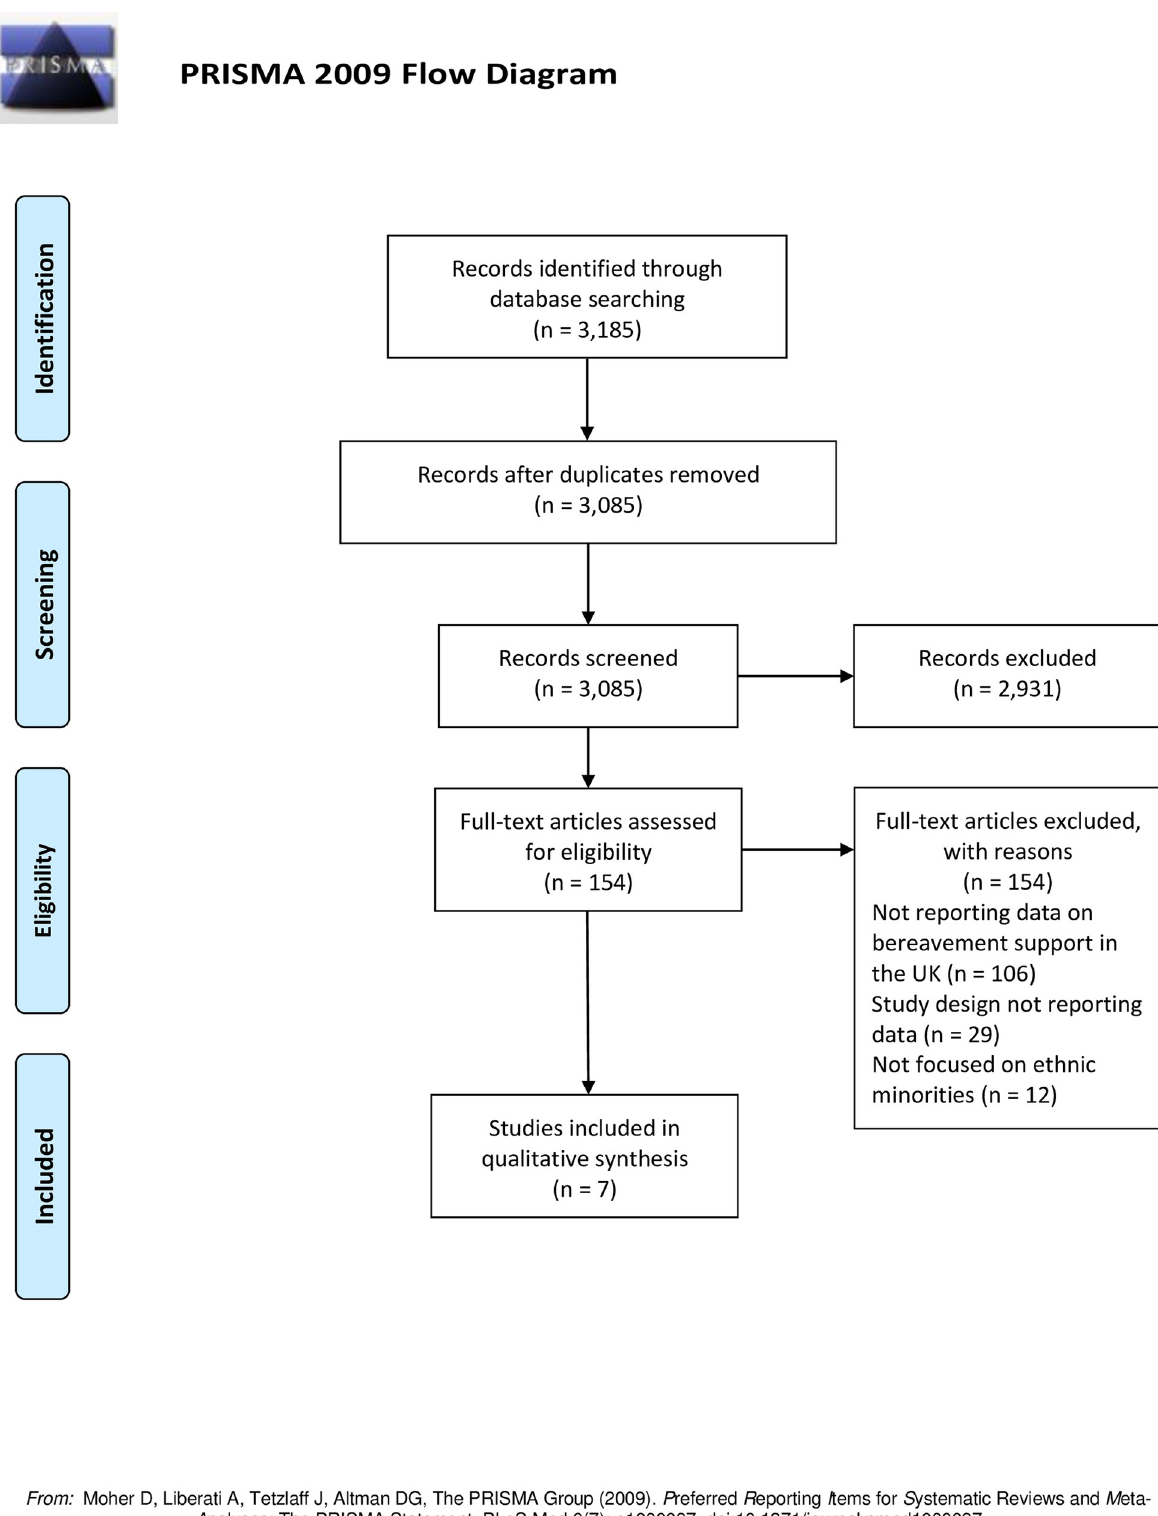
Fig 1. PRISMA flow chart outlining screening and inclusion of articles in the review. https://doi.org/10.1371/journal.pone.0252188.g001 PLOS ONE | https://doi.org/10.1371/journal.pone.0252188 June 30,